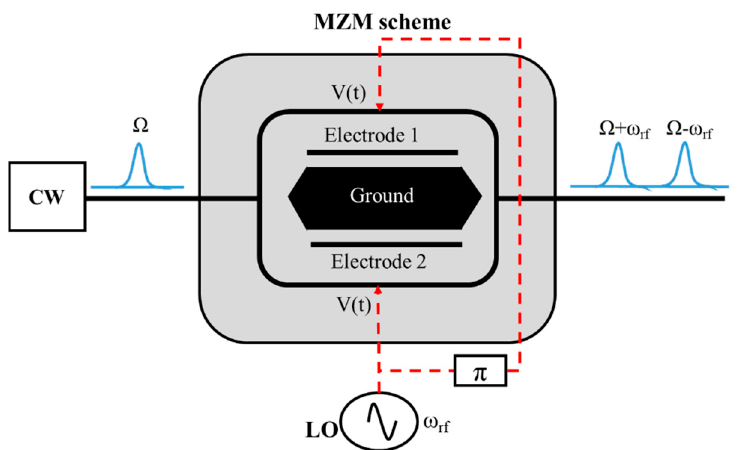
Figure 1. DSB-OCS schematic diagram.